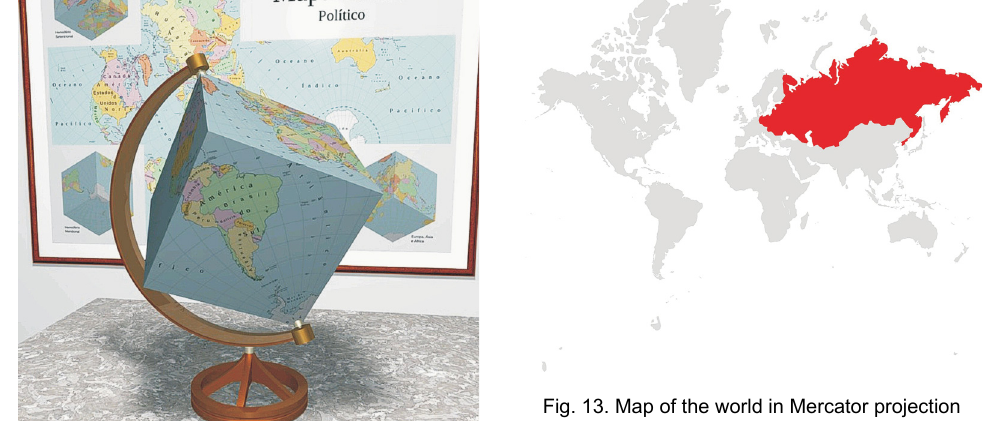
Fig. 13. Map of the world in Mercator projection